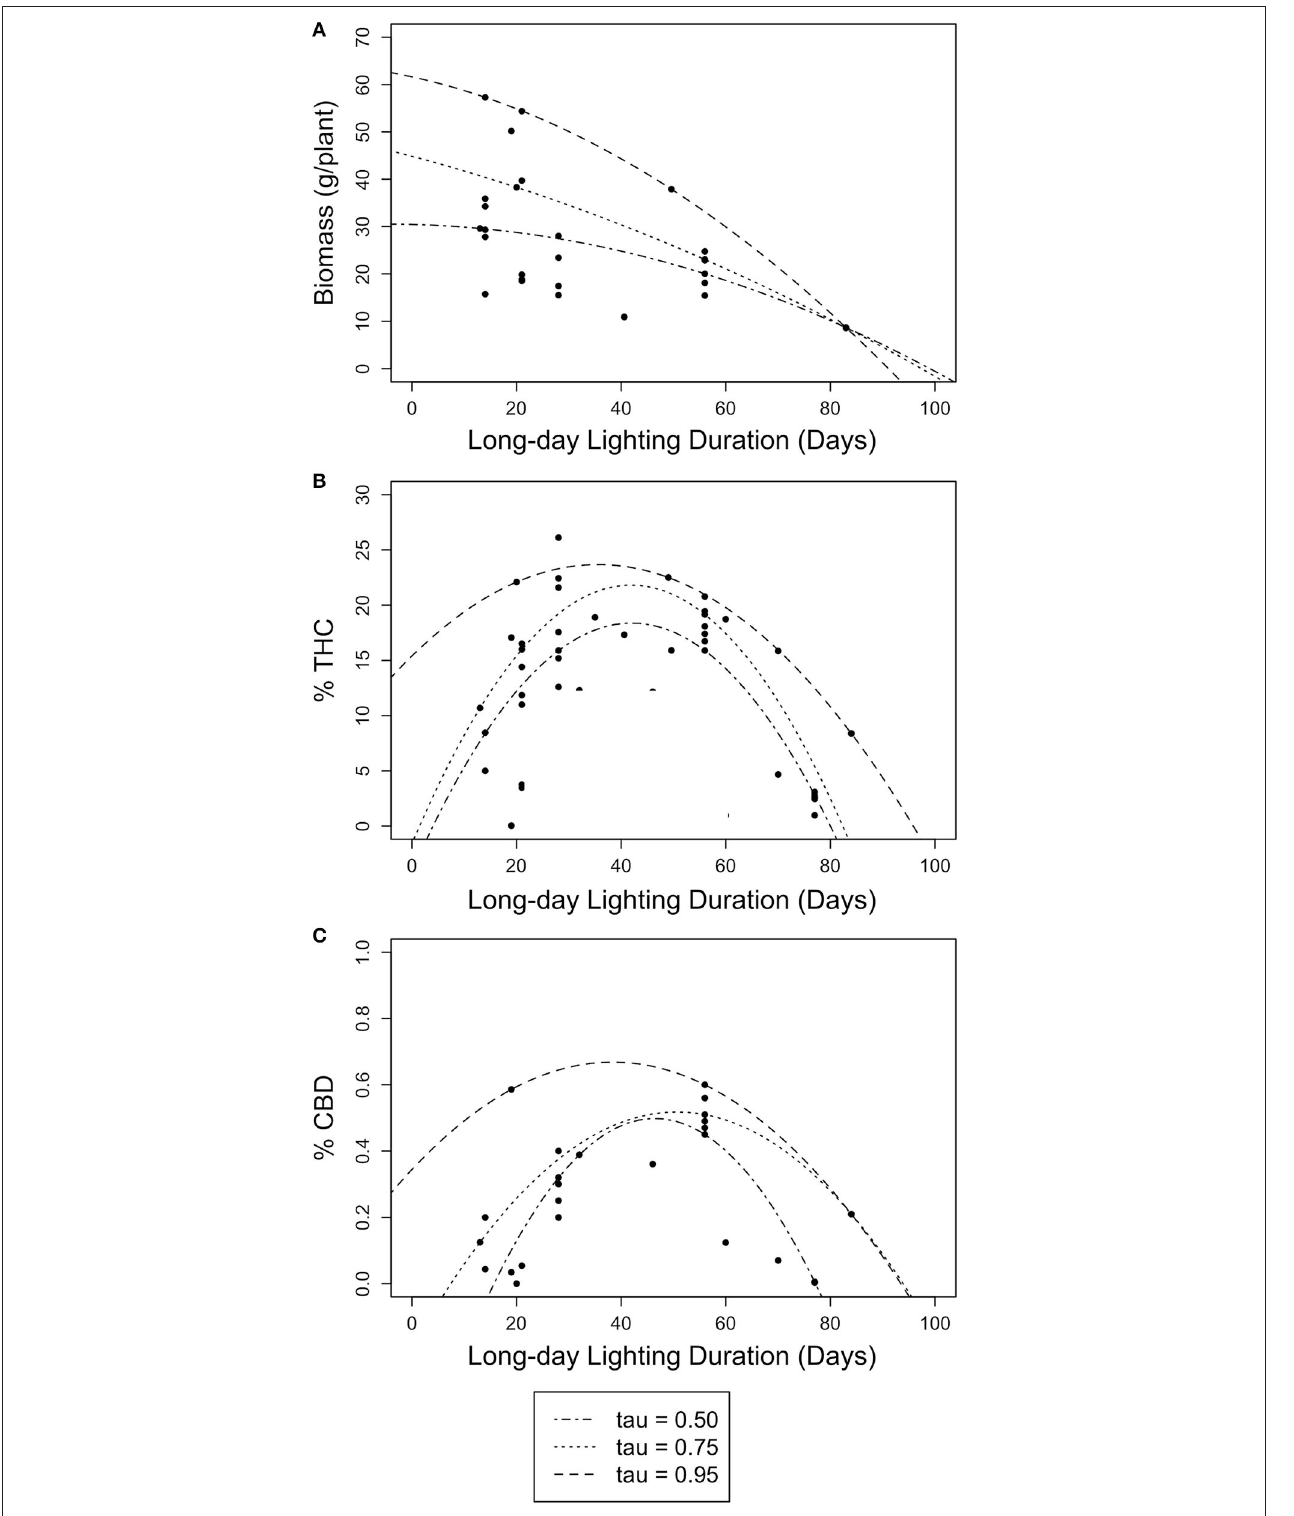
FIGURE 3 | Scatter plots of non-linear quantile regression results for long day length durations (days) with floral biomass (g/plant) and cannabinoid concentration (% THC and % CBD). Lines represent 50th (dotted-dashed), 75th (dotted), and 95th (dashed) quantile regressions. (A) The relationship between long day length duration and floral biomass (g/plant). (B) The relationship between long day length duration and THC concentration (% THC). (C) The relationship between long day length duration and CBD concentration (% CBD).